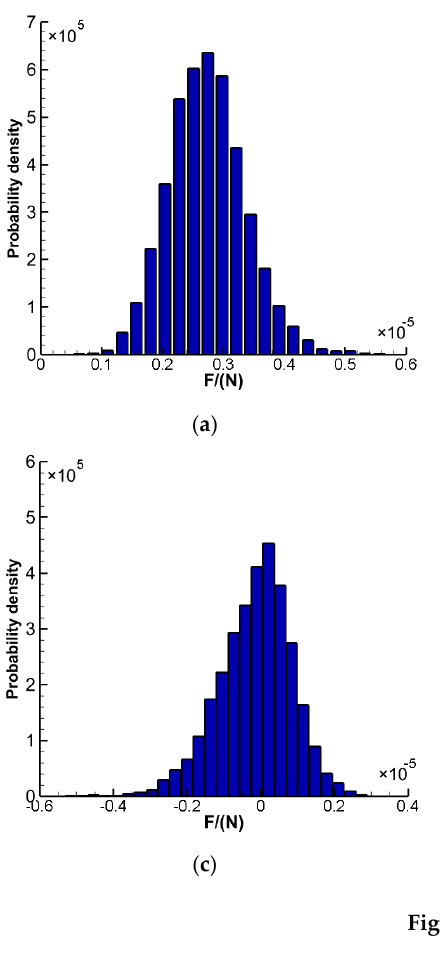
Figure 14. Timelines of F y ( a ) Sensor 1; ( b ) Sensor 2; ( c ) Sensor 3; ( d ) Sensor 4; ( e ) Sensor 5; ( f ) Sensor 6; ( g ) Sensor 7; ( h ) Sensor 8.